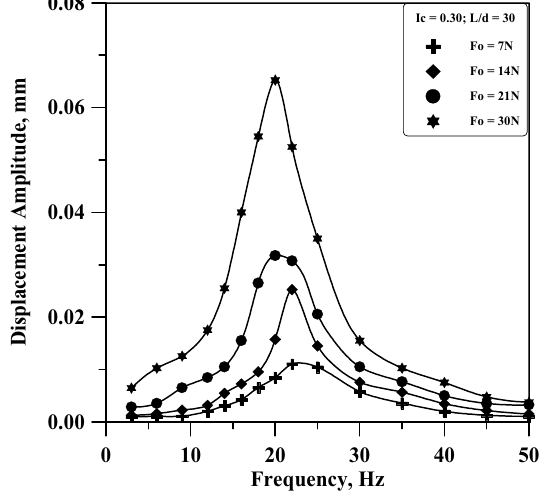
Fig. 6. Frequency response curve for I c = 0.30; L/d = 30.